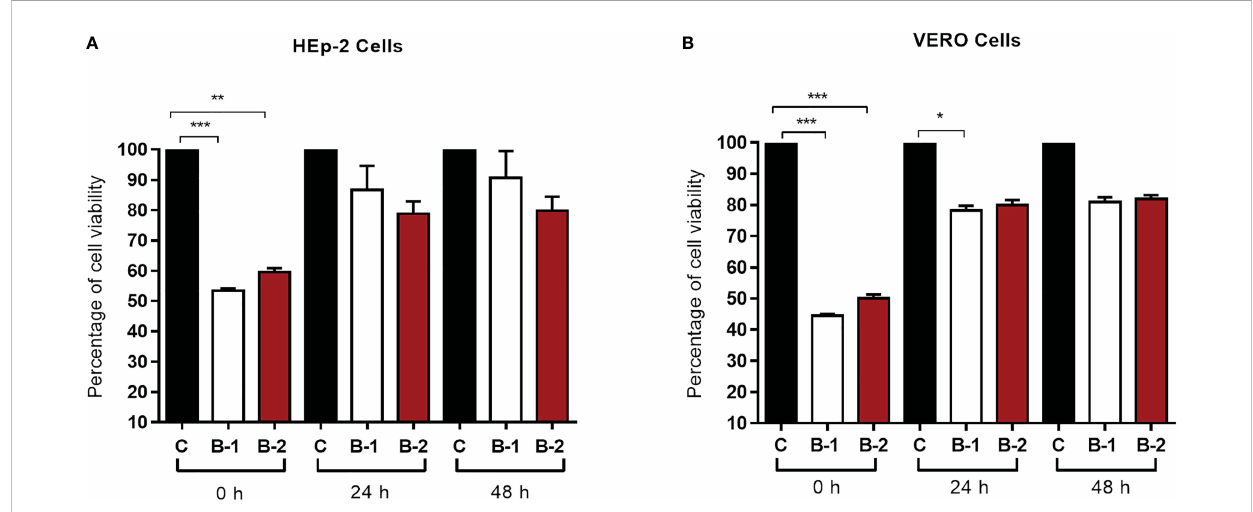
FIGURE 1 The HRA2pl peptide does not affect cell viability of (A) HEp-2 and (B) Vero cultures. For the assay, a con fl uent monolayer of HEp-2 and Vero cells (95% – 100%) was treated with 90 m L of HRA2pl puri fi ed in DMEM (B1: 172.31 ng/ m L; B2: 182.9 ng/ m L) and 10 m L of AlamarBlue to measure the absorbance at 0 h, 24 h, and 48 h. NS : Nonsigni fi cant; *p< 0.05; **p< 0.01; ***p<